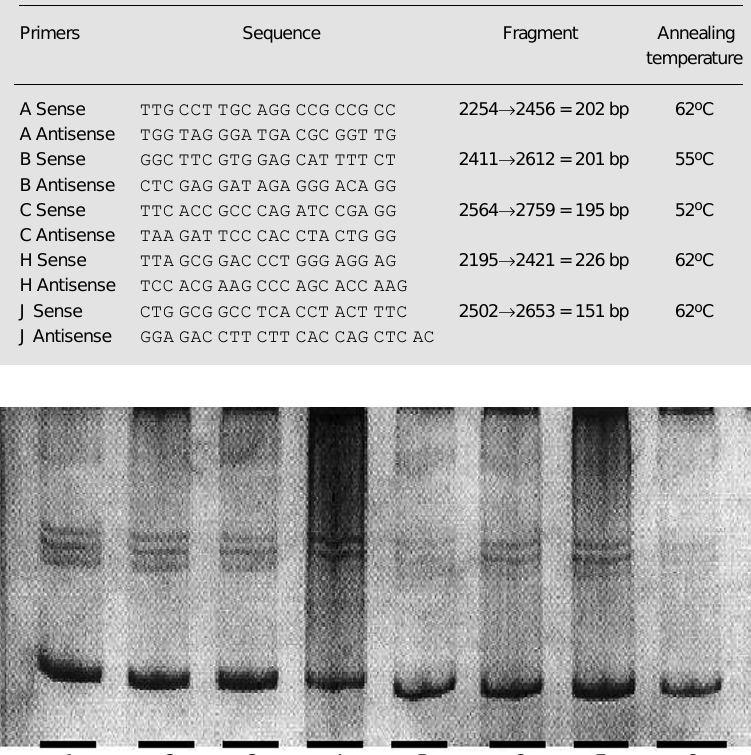
Table 1. Primers used to amplify the exon 2 sequence of the MEN1 gene. The sequence of the primer, the localization and length of the corresponding fragment and the annealing tempera- ture of each primer are described.